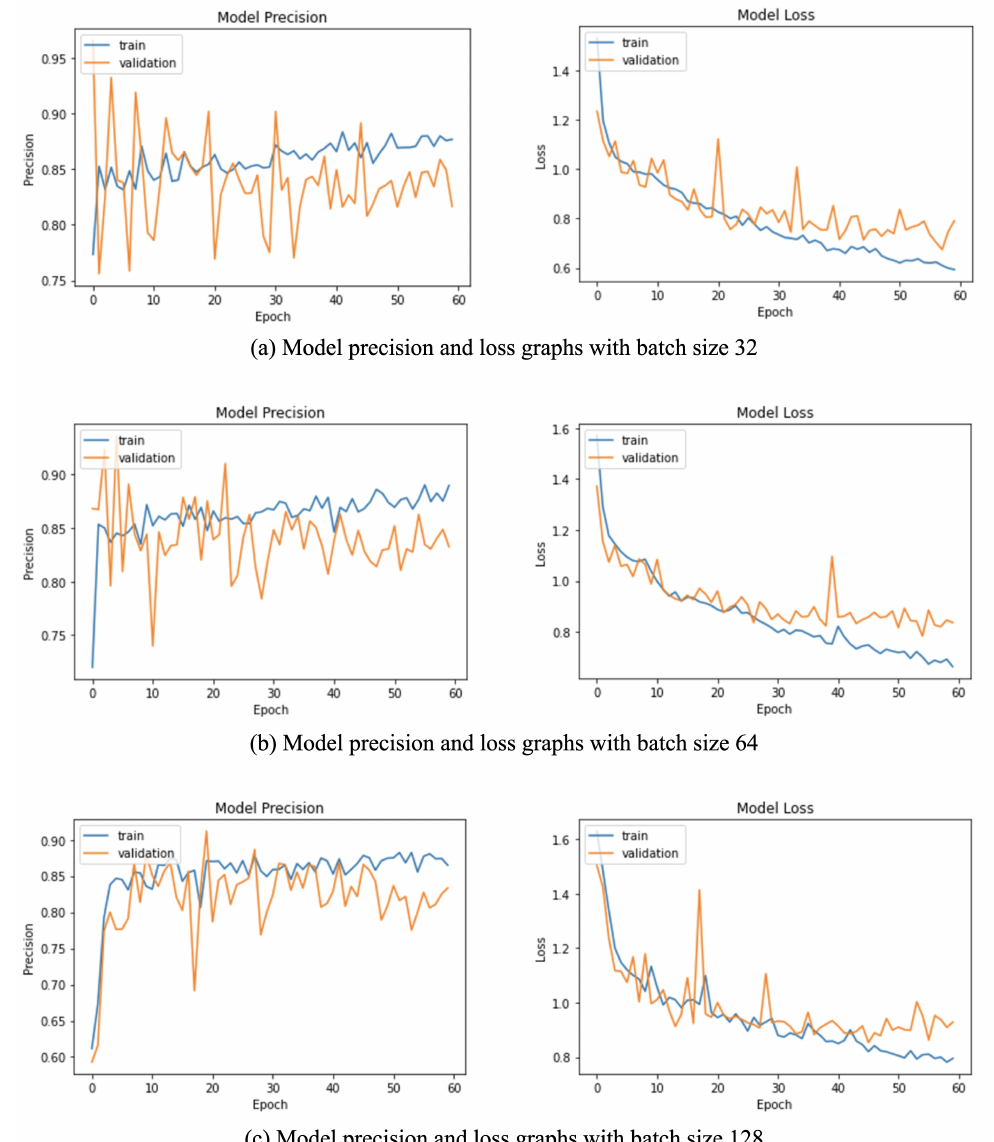
Figure 6. Model training graphs with smaller batch sizes result in unstable learning depicted by the oscillating precision and loss curves. In contrast, larger batch sizes ensure that batches have a good representation of input samples from each class. However, larger batch sizes also cause the learning to regularize too much and worsens the performance of the network. A batch size of 64 provides a balance of smooth learning with a low loss value at the end of the training and was chosen as a model